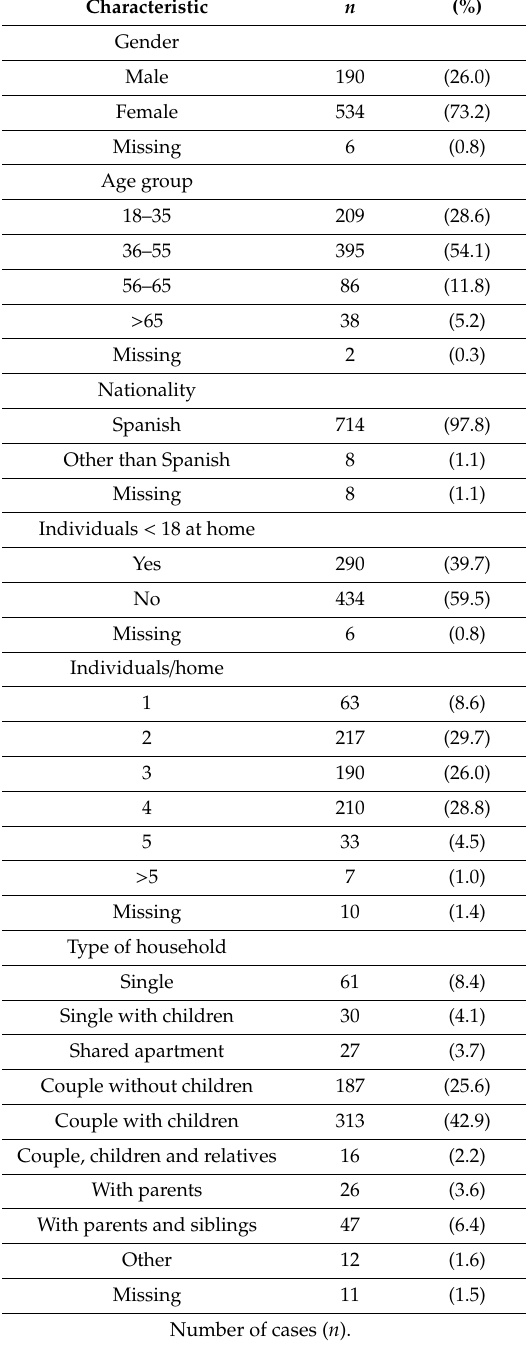
Table 1. Sociodemographic characteristics of participants ( n =